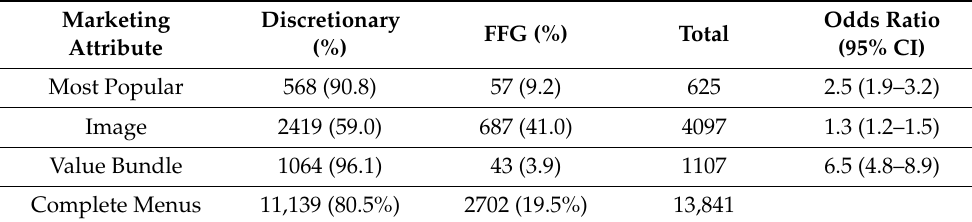
Table 3. The proportion of discretionary menu items compared against FFG menu items within marketing attribute subgroups and complete menus 1 .